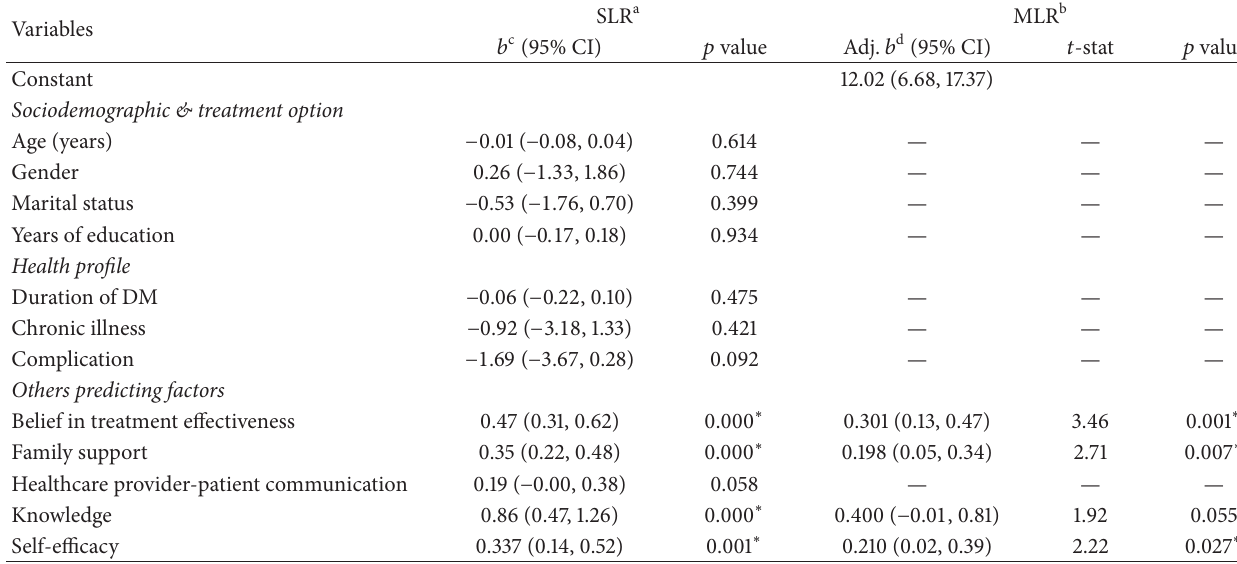
Table 4: Factors predicting the